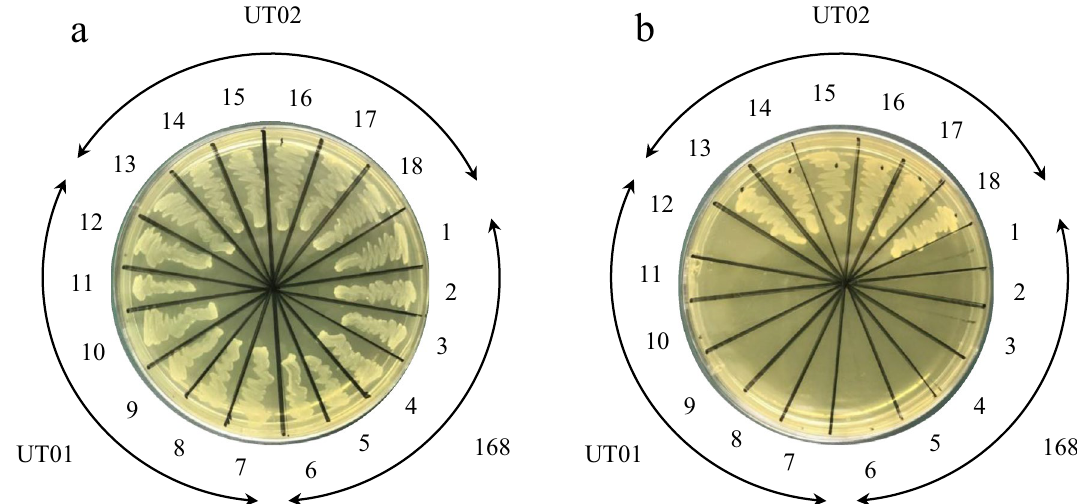
Figure 2. Introduction of the Ldb1381-1386 region from JCM 1002 T allowed B. subtilis to utilize inulin. Six clones of UT001 ( amyE ::Ldb0438-0442, No. 7-12) and UT002 ( amyE ::Ldb1381-1386, No. 13-18) obtained just after transformation were grown with the parental 168 strain (No. 1-6) on minimal medium containing ( a ) glucose or ( b ) inulin at 37 °C for 48